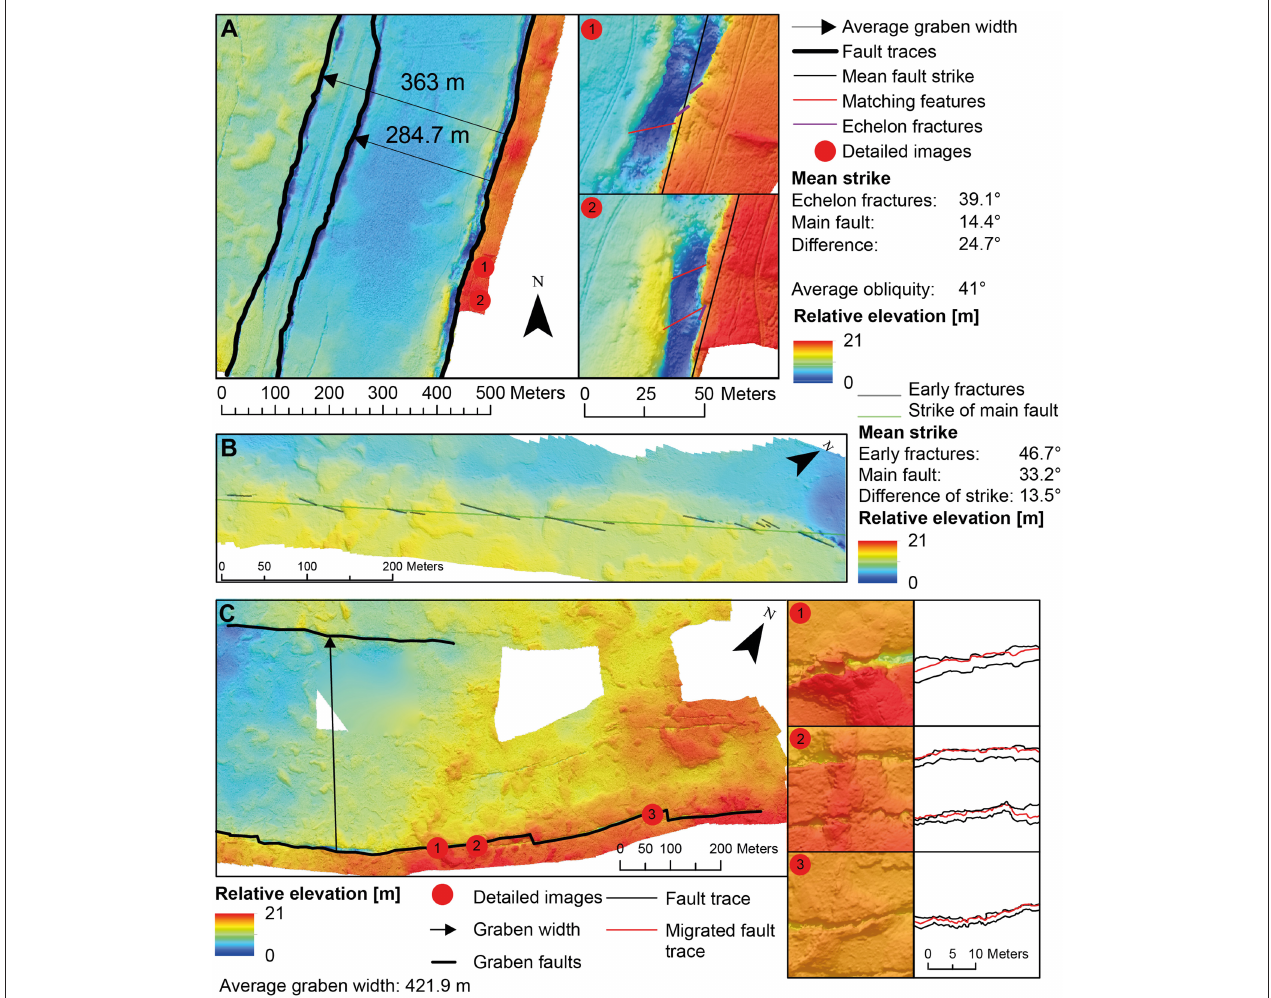
FIGURE 12 | High resolution digital elevation models of the selected field sites where obliquity can be determined. Fault (A) shows two antithetic faulty that can be used for determining graben width. Insets 1 and 2 show how both fracture surfaces can be linked. Fault (B) shows a series of early fractures and their angle to the main fault. Early fractures are indicative for fault obliquity. Fault (C) shows no obliquity, as determined by matching the respective fracture surfaces on both